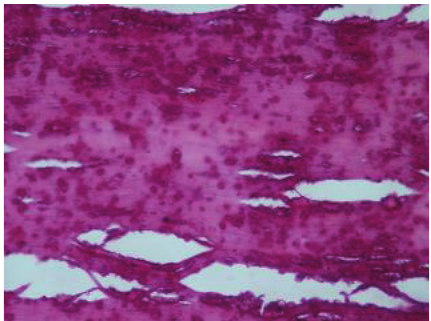
Figure 5: Histopathology slide showing stretched out nuclei at periphery without